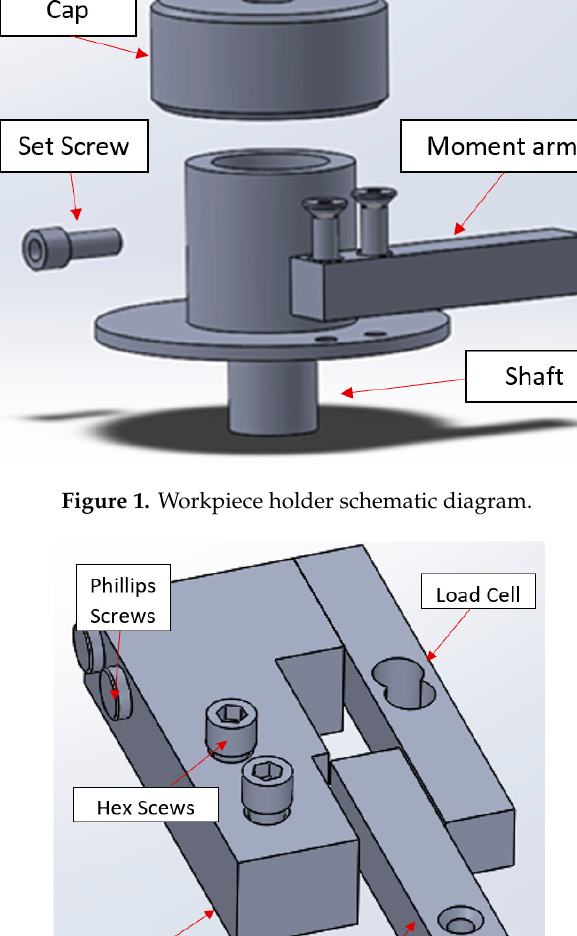
Figure 1. Workpiece holder schematic diagram.